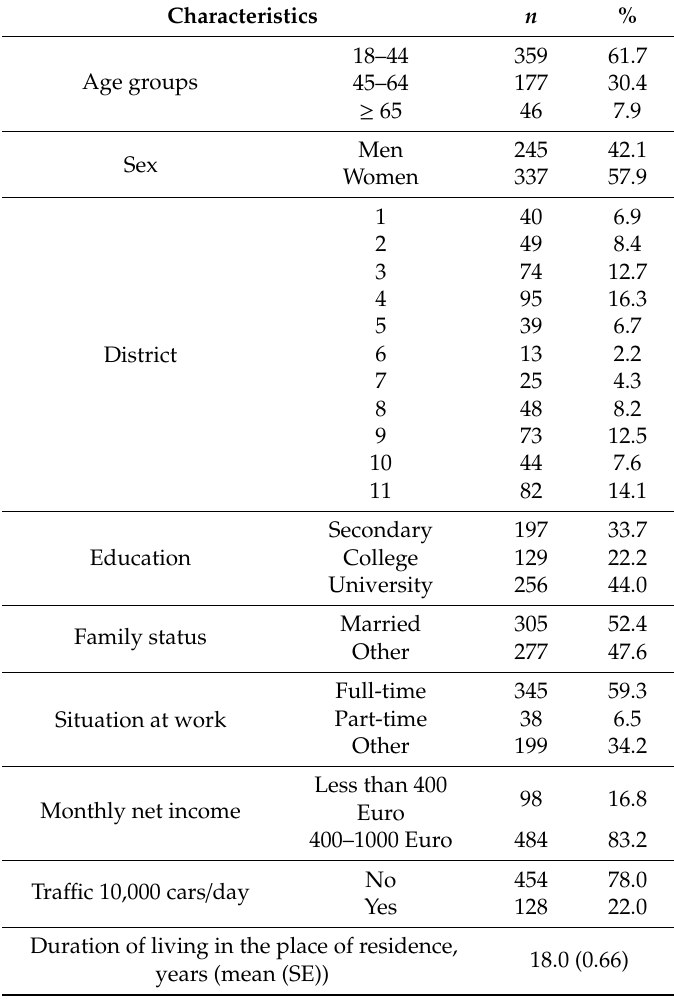
Table 1. Characteristics of the participants living in Kaunas